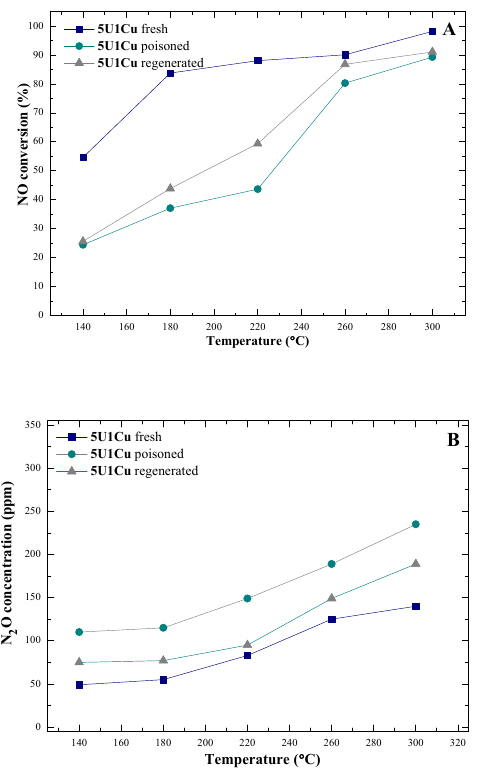
Figure 7. Results of catalytic tests carried out over fresh, poisoned, and regenerated 5U1Cu: ( A ) NO conversion; ( B ) N 2 O concentration.